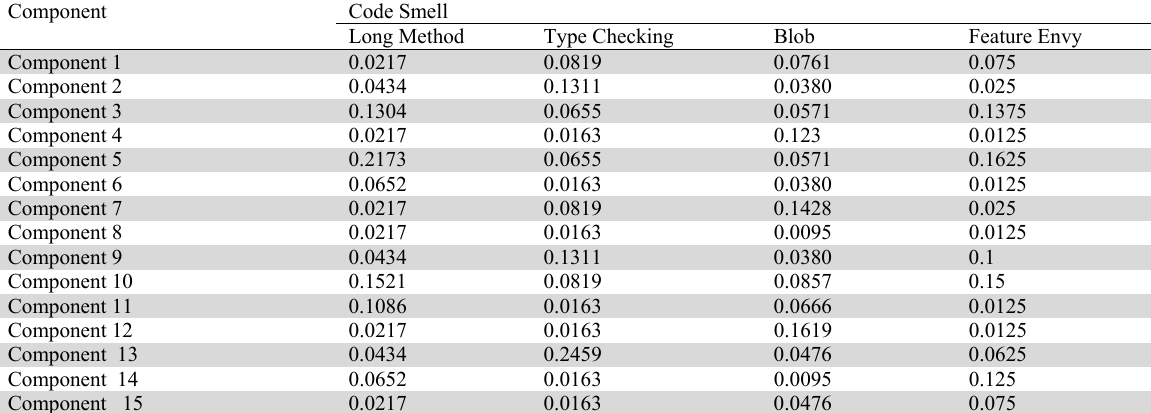
Normalized value of the code smell Component Code Smell Component